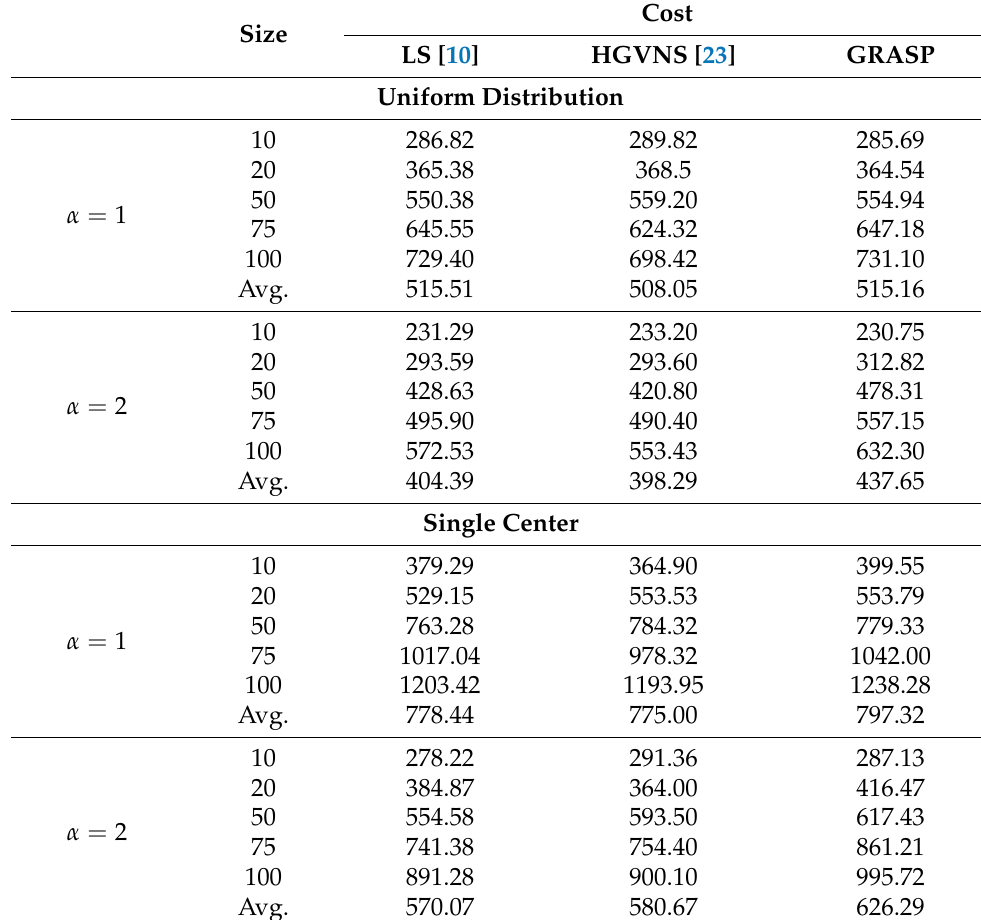
Table 4. Performance comparison of the models obtained by the LS [10], a TSP-D version of the HGVNS [23], and the proposed GRASP HCLS variant, showing the average solution cost in sec